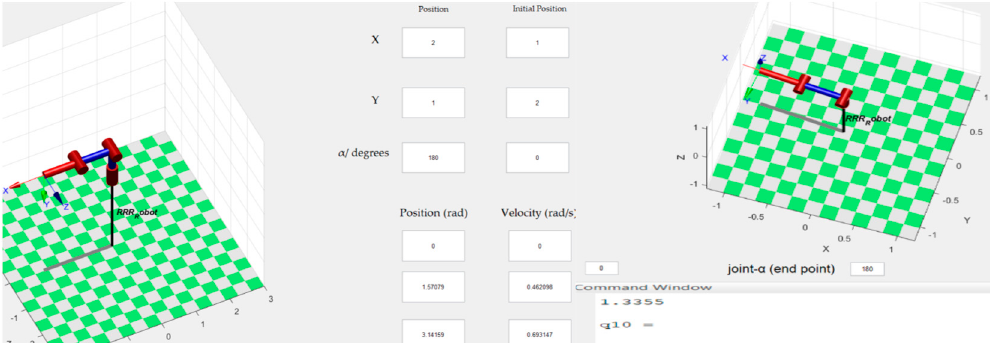
Figure 14. Simulation results of the alpha-join trajectory using distribution function proposed and cubic polynomial with a trajectory of 1 s.